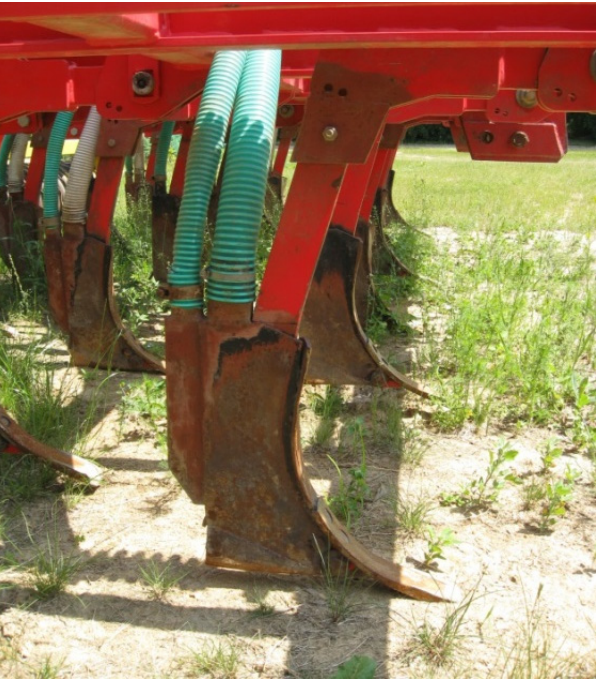
Figure 1. The sweep for deep mineral fertilizer application used in soybean cultivation technology. Before sowing the soybean seeds, mineral fertilizer was applied in the form of Polifoska ® 6 NPK(S) 6-20-30(7), at a rate of 200 (F85) or 400 (F170) kg · ha − 1 . The per- centage content of all nutrients in the applied fertilizer was as follows: N—6%; P 2 O 5 —20%; K 2 O—30%; SO 3 —7%. In total, the mineral fertilization was the following (per hectare): F85 = 12 kg N, 17.5 kg P, 50 kg K, 5.5 kg S (85 kg NPKS · ha − 1